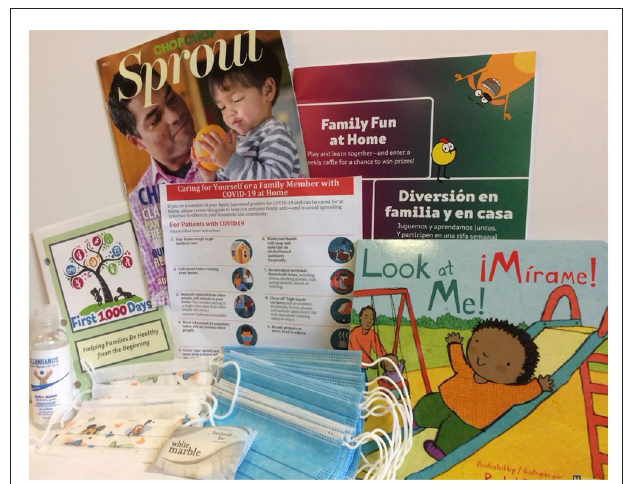
FIGURE 3 | HUGS/Abrazos COVID-19 care package for